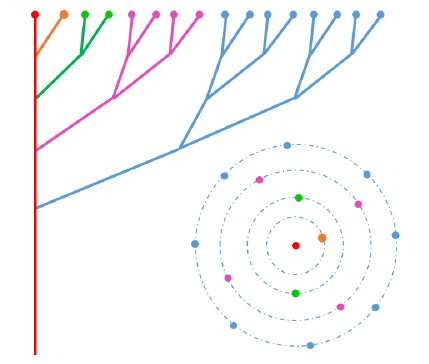
Figure 2. The boundary of the BT tree can be viewed as a 2 d plane. The boundary points of a same color branch have the same norm and are on the same